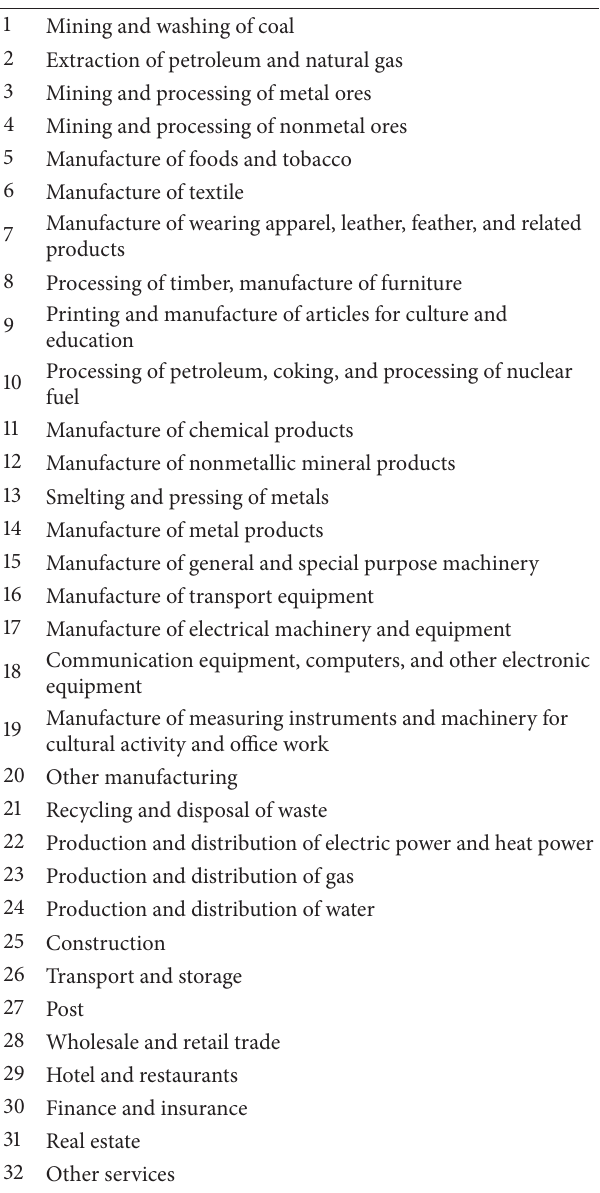
Table 1: Sectoral classification of the input-output